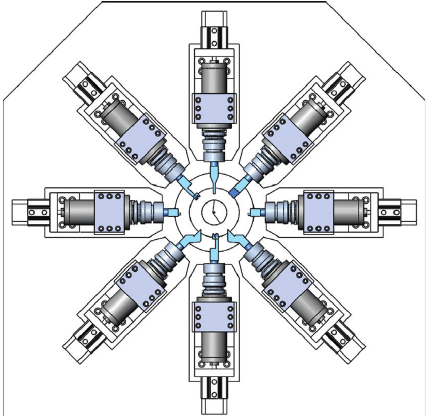
Figure 5: Spring formed panel with the automatic loose-clamp function of tool.